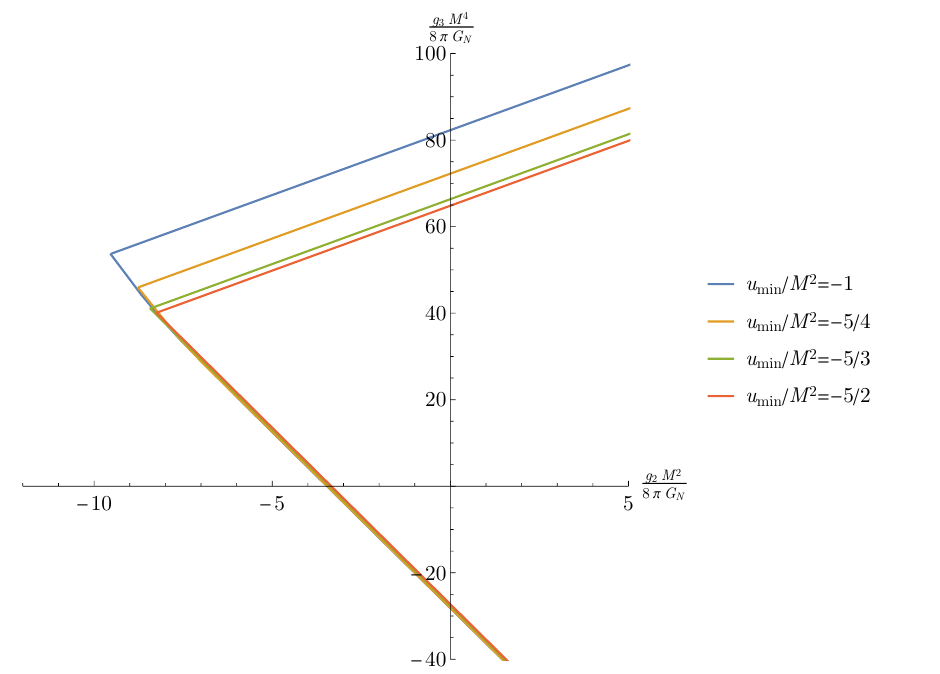
Figure 9 . Bounds on g 2 , g 3 in D = 6 , computed using wavepackets with support in u ∈ [ u min , 0] for u min /M 2 = − 1 , − 5 / 4 , − 5 / 3 , − 5 / 2 . As u min gets more negative, the kink slides along the lower bound on g 3 . These bounds were computed using a 54-dimensional space of functionals spanned by { p n C improved | n = 1 . 5 , . . . , 19 . 5 } ∪ { p n X k | ( n, k ) ∈ { (0 , 4) , . . . , (11 , 4) } ∪ { (0 , 6) , . . . , (9 , 6) } 2 , − p 2